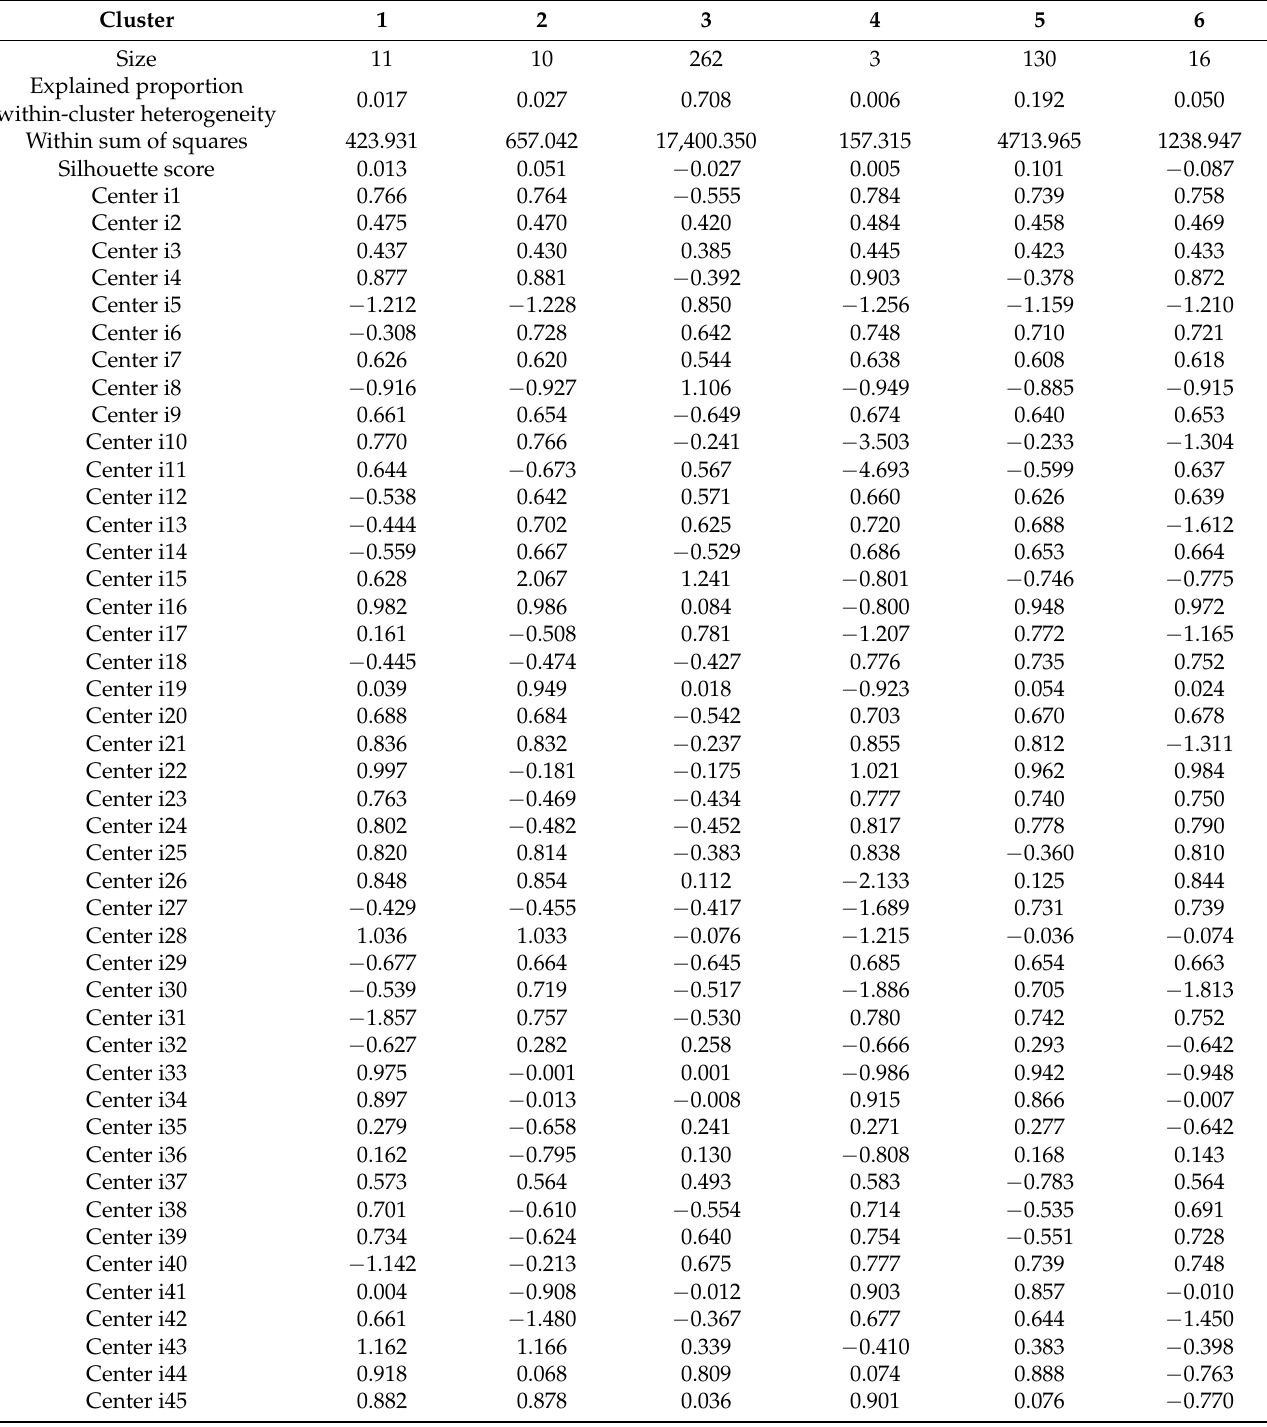
Table 2. Fuzzy c-means clustering